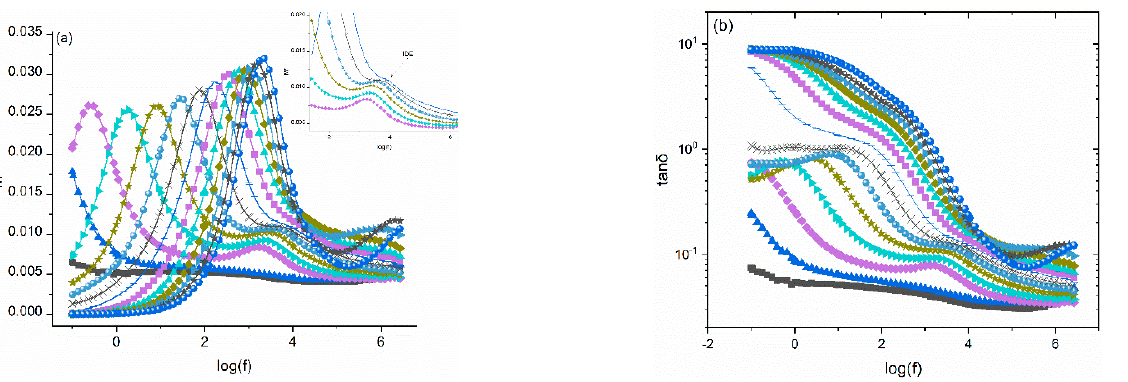
Figure 6. Imaginary part of electric modulus ( a ) and loss tangent ( b ) versus frequency for the 40 phr SrFe 12 O 19 /10 phr BaTiO 3 /epoxy nanocomposite. Notation of temperature is the same with Figure 5.